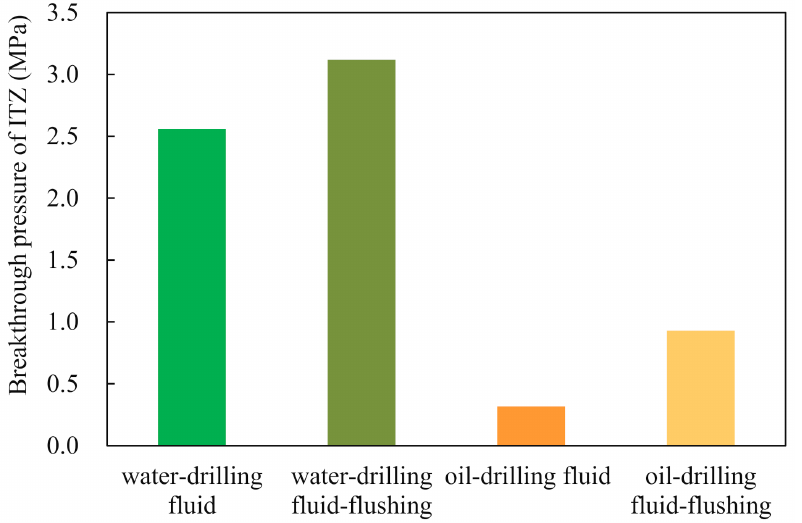
Figure 5. Impact of drilling fluids on the breakthrough pressure of ITZ . Drilling fluid and flushing fluid are from the construction